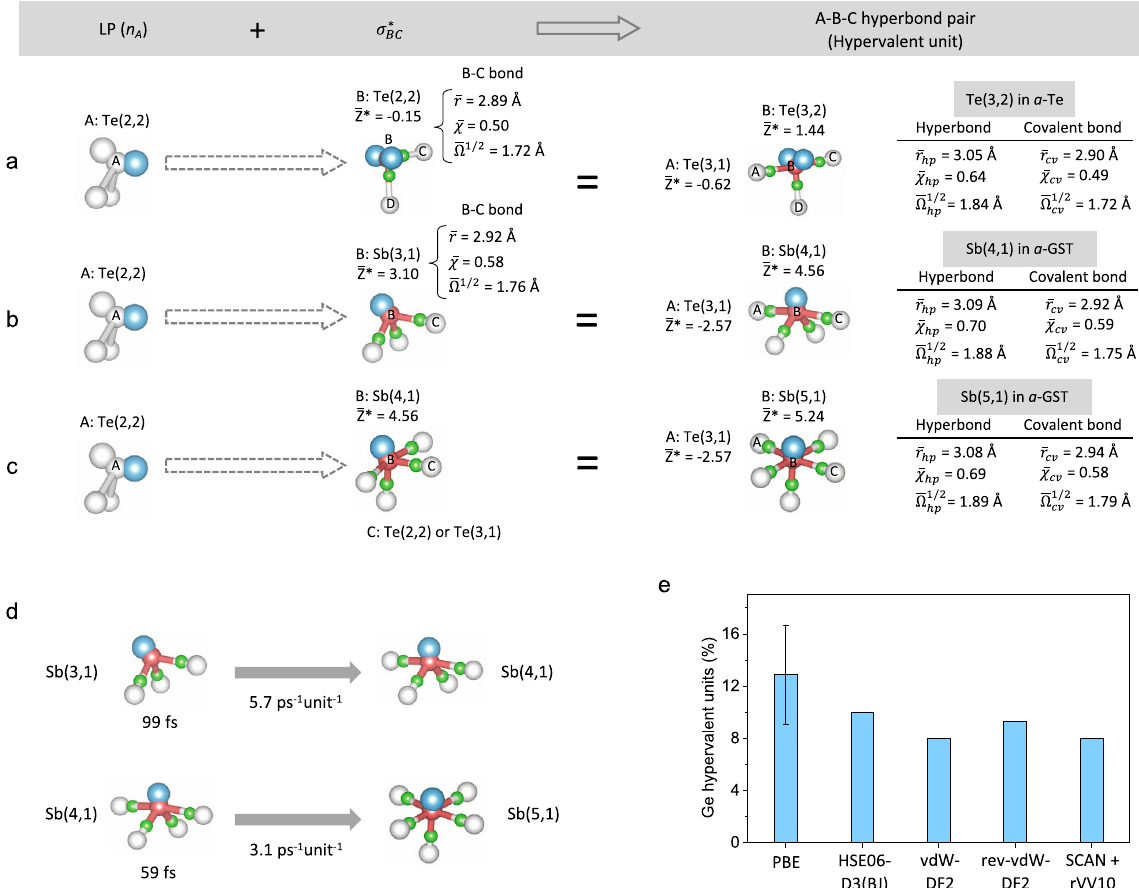
Fig. 4 Proposed formation processes of representative hypervalent units. The hyperbonding interactions of an LP of the central Te (A) atom of a (2,2)- type unit with an antibonding orbital of a nearby bond (B-C) of: a Te(2,2) in a -Te; b Sb(3,1) in a -GST; and c Sb(4,1) in a -GST. For each hypervalent unit, its corresponding mean Born effective charge, as well as the properties of their covalent bonds and hyperbonds, are compared in a – c . The A-B-C triatomic bonding con fi guration consists of a hyperbond pair (A-B and B-C). A central atom (B), together with corresponding MLWF centres for LPs (cyan) and bonds (green), constitutes each structural unit. d The lifetime of Sb(3,1) and Sb(4,1) units, and their transition rate (per ps per unit) to the associated hypervalent unit in a -GST at 700 K, calculated from the trajectories of structural units in AIMD simulations. e Variation of the population of Ge hypervalent units in a -GeTe with the inclusion of various dispersion-interaction corrections 40 – 43 . The error bar for the PBE functional represents the standard deviation among independently-generated a -GeTe